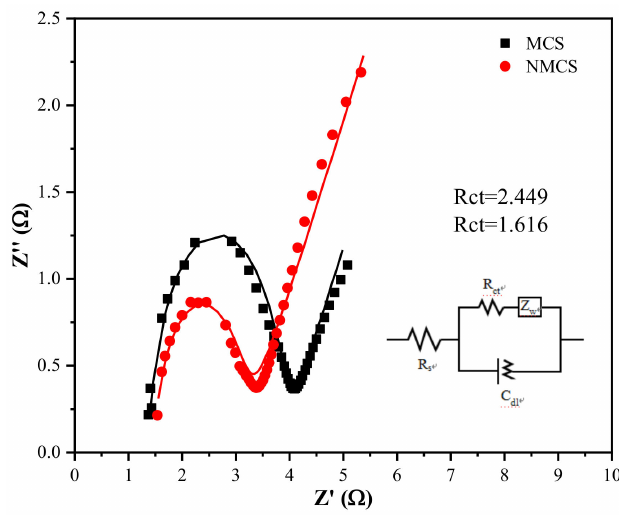
Figure 5. EIS curves of MCS and